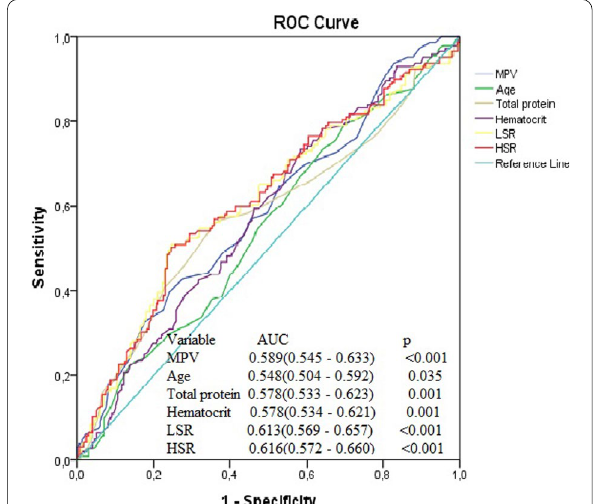
Fig. 1 Receiver operating characteristics curve analysis of MPV, age, total protein, haematocrit LSR and HSR in predicting high thrombus